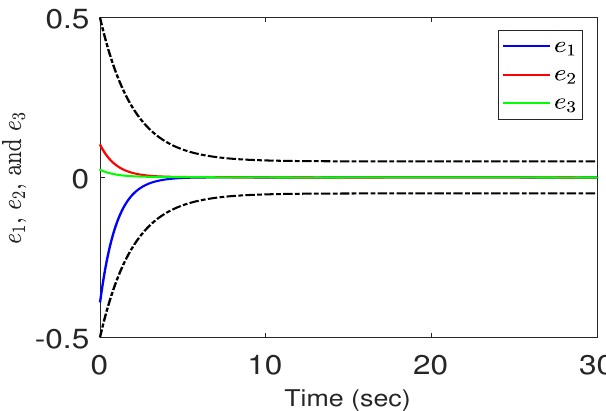
Figure 4. Tracking errors vs. time under a PPC in Case 1. Table 1. Pseudo code for the proposed control algorithm.